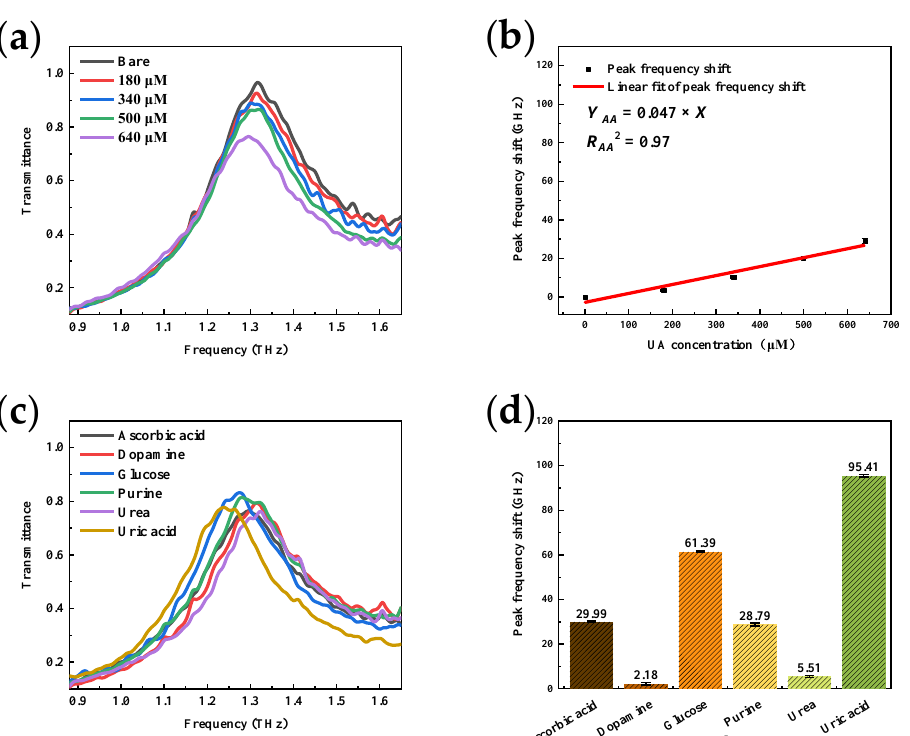
Figure 9. Detection results of the same sensor with different analytes: ( a ) Peak frequency shift with AA; ( b ) Sensor calibration curve in UA assay; ( c ) Corresponding response of different analytes; ( d ) Peak frequency shift of different analytes .